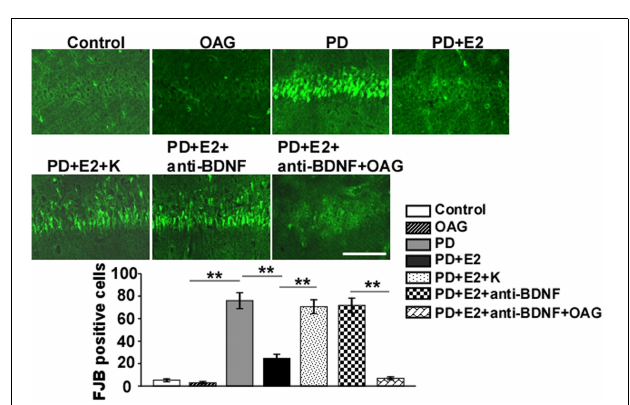
FIGURE 8 | Representative micrographs showing the changes in neuronal death by FJB staining of the hippocampal CA1 area in the control group, OAG group, PD group, PD + E 2 group, PD + E 2 + K group, PD + E 2 + anti-BDNF group, and PD + E 2 + anti-BDNF + OAG group. Quantitative analysis of the FJB-positive cells in the CA1 ( n = 7). All data are expressed as means ± SEM. ( n = 7, each group). ** p < 0.01. Scale bar = 100 µ